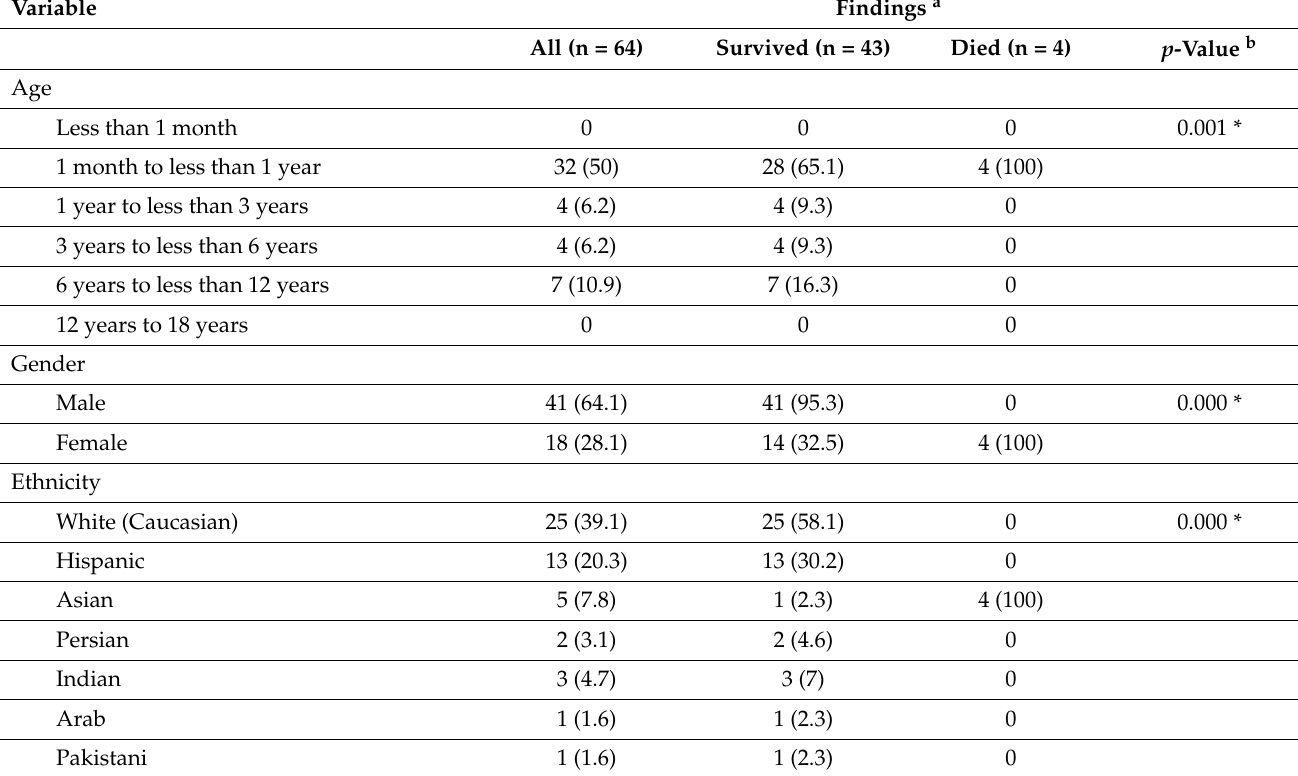
Table 2. Demographic data of the pediatric SARS-CoV-2 patients with ISN, stratified by treatment outcome (n = 34 studies),